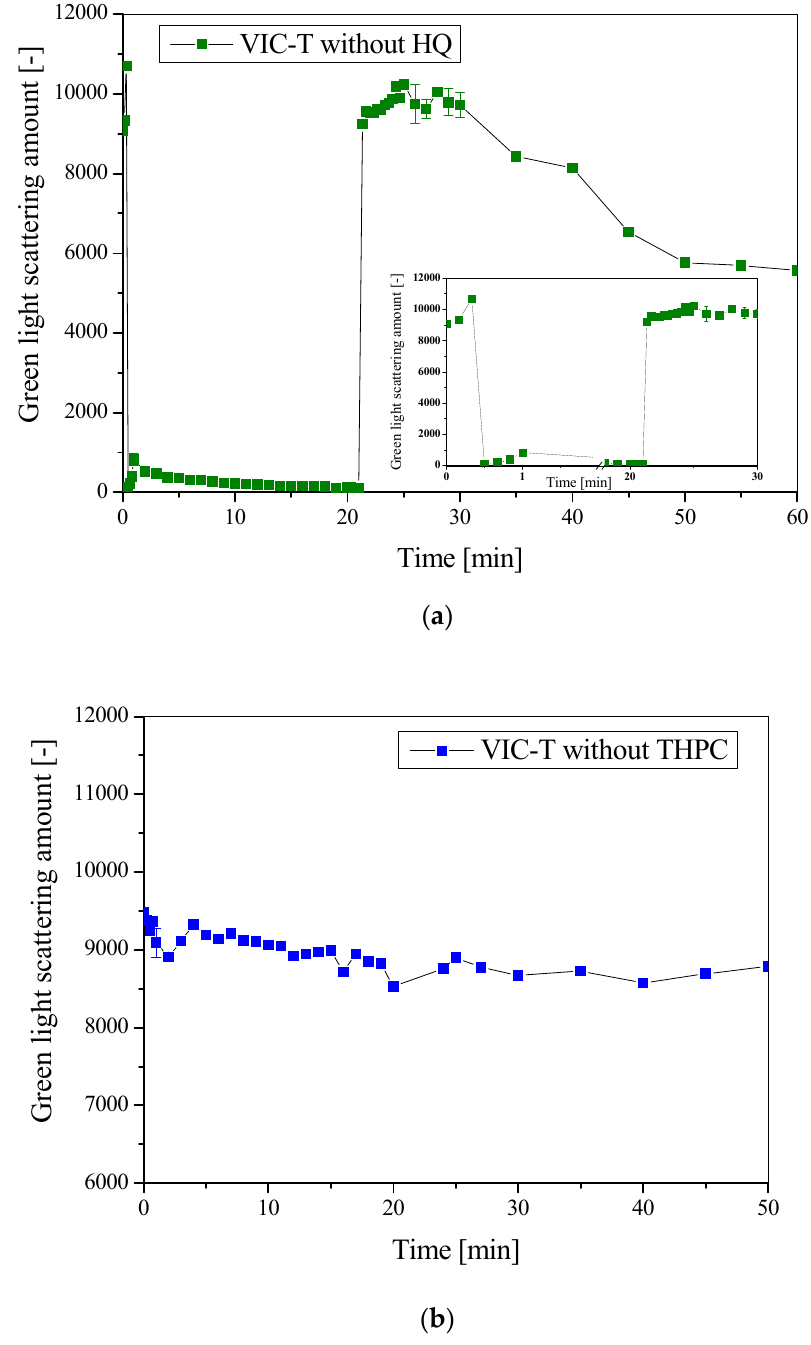
Figure 2. The green laser light (532 nm, 5 mW) scattering intensity (SLS) measurements at 90° for VIC-T over time after preparation: ( a ) is for VIC-T without HQ (at 23 °C) and ( b ) is for VIC-T without THPC (at 19 °C). Inset in ( a ) is for a narrower time range to visualize the initial period of measurements.